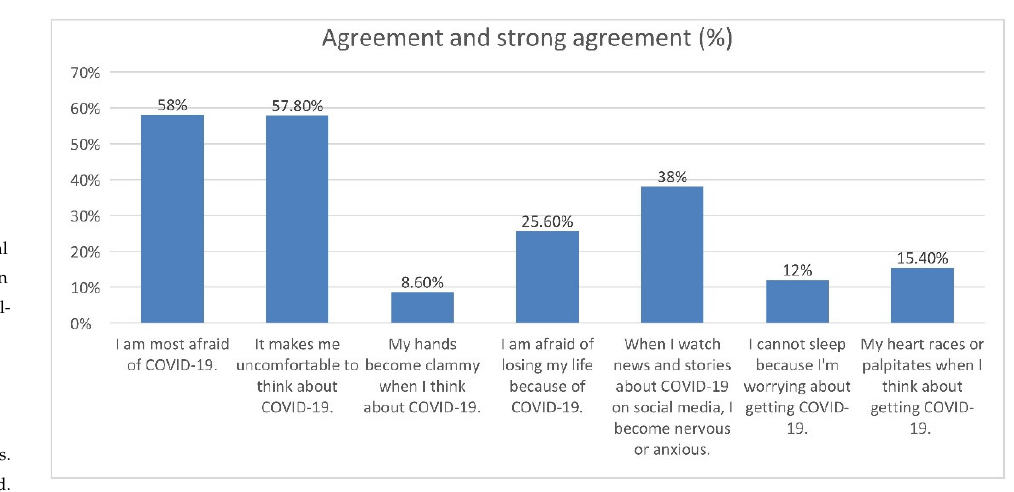
Figure 1. Participants agreement on seven items of The Fear of COVID-19 Scale 1. Figure/Table Legend, Error in Figure/Table (FCV-19S).